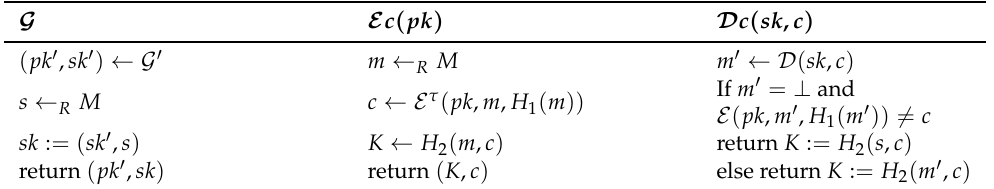
Table 4. Algorithms defining KEM (cid:54)⊥ = U (cid:54)⊥ [ π τ , H ] .